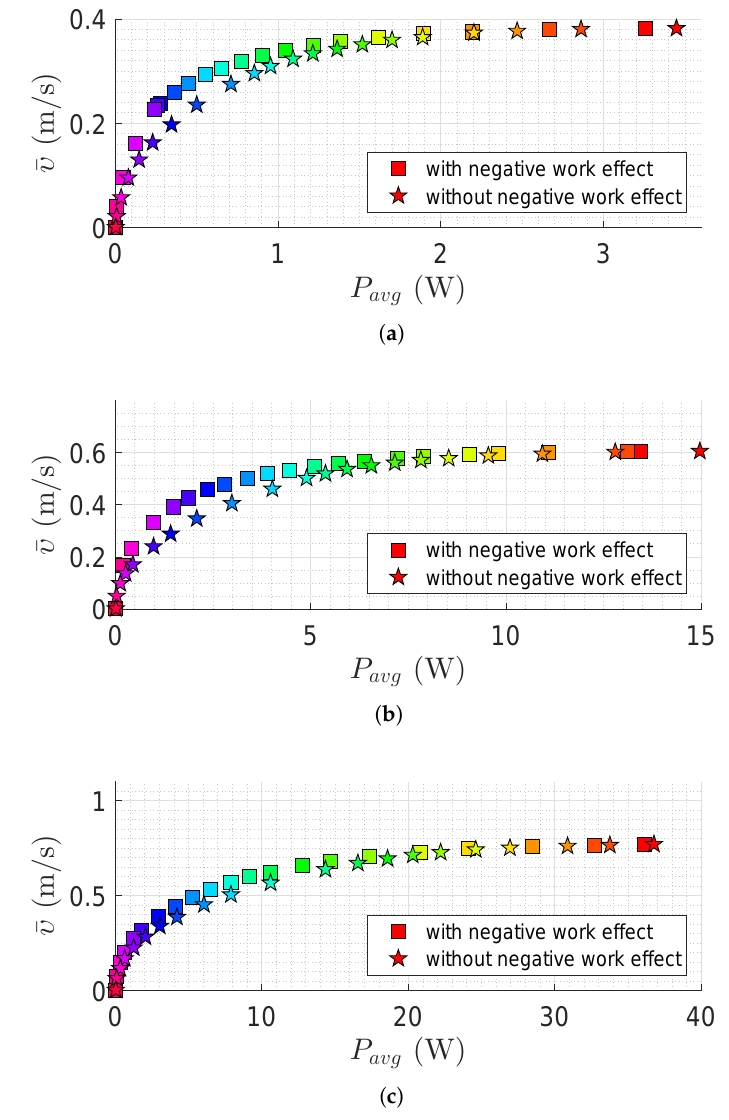
Figure 5. Pareto front for the USR using the eel-like motion pattern: ( a ) Pareto front for robot with n = 5 links; ( b ) Pareto front for robot with n = 10 links; and ( c ) Pareto front for robot with n = 20 links. Colors illustrate different weights of the objective